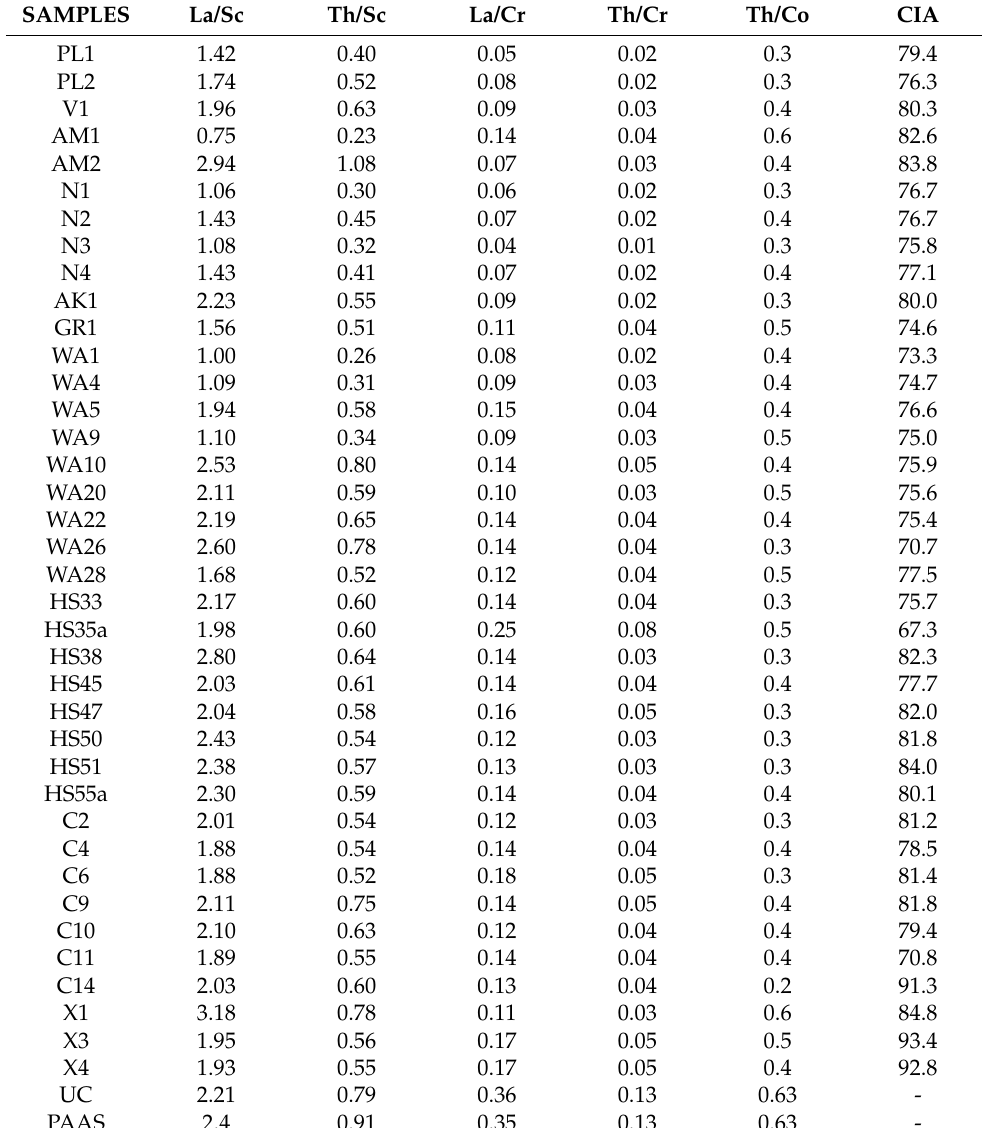
Table A3. Elemental ratios for all the samples from the northern Peloponnese and south Epirus, and the chemical index of alteration (CIA).